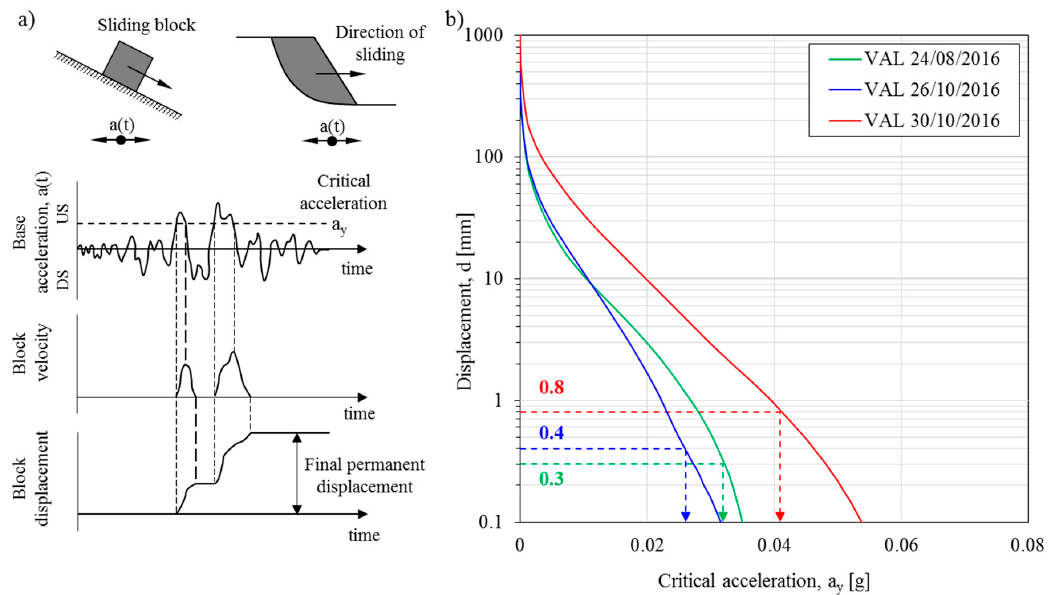
Figure 12. ( a ) Newmark sliding block concept for slopes; ( b ) relationship between permanent displacement (d) and critical acceleration (a y ) for the three selected signals; the arrows show the critical acceleration related to the observed displacement of the